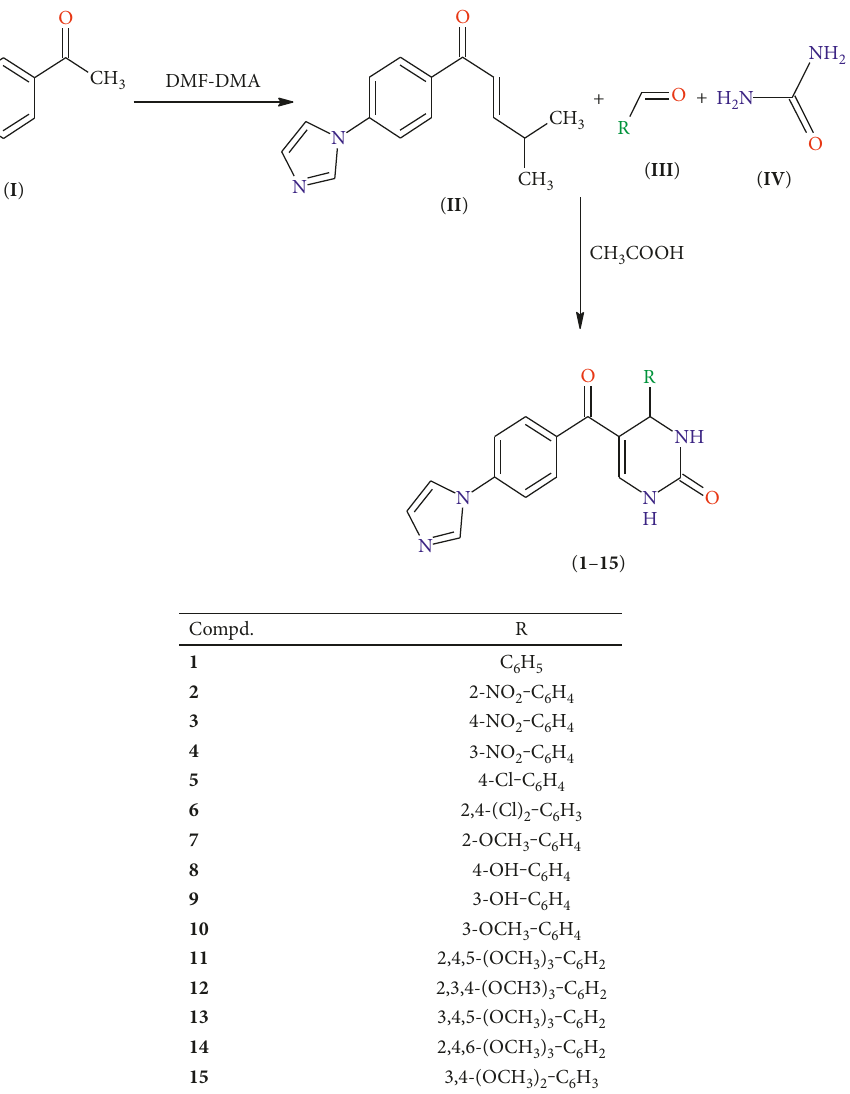
Scheme 1: Reaction scheme for the synthesis of dihydropyrimidinone derivatives containing imidazole 2.3.12. 5-[4-(1H-imidazol-1-yl)benzoyl]-4-(2,3,4-trimethox- yphenyl)-3,4-dihydropyrimidin-2(1H)-one (12 ). Yield: 72%;